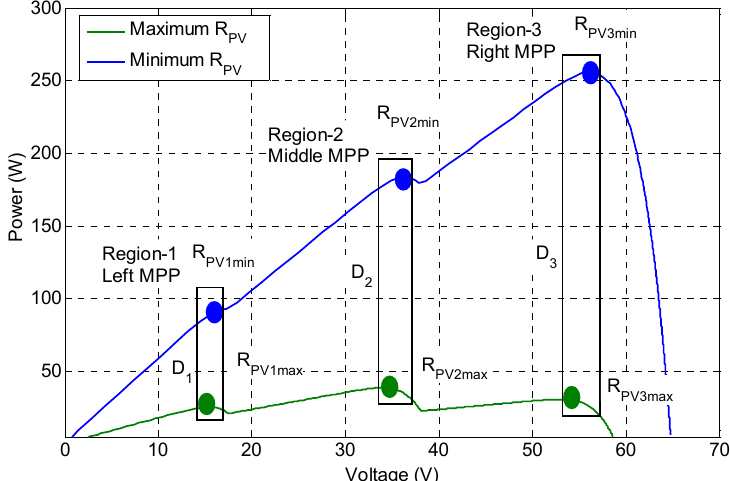
Figure 5. Minimum and maximum equivalent resistance (ER) of photovoltaic (PV) module at maximum power points (MPPs).